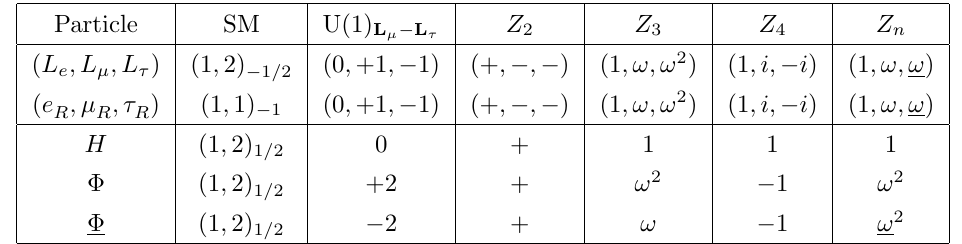
Table 1 . Particle contents of models based on U(1) L numbers of the SM are also shown in the notation of symmetry Z n , ! is a conjugate of ! , where ! is n -th root of